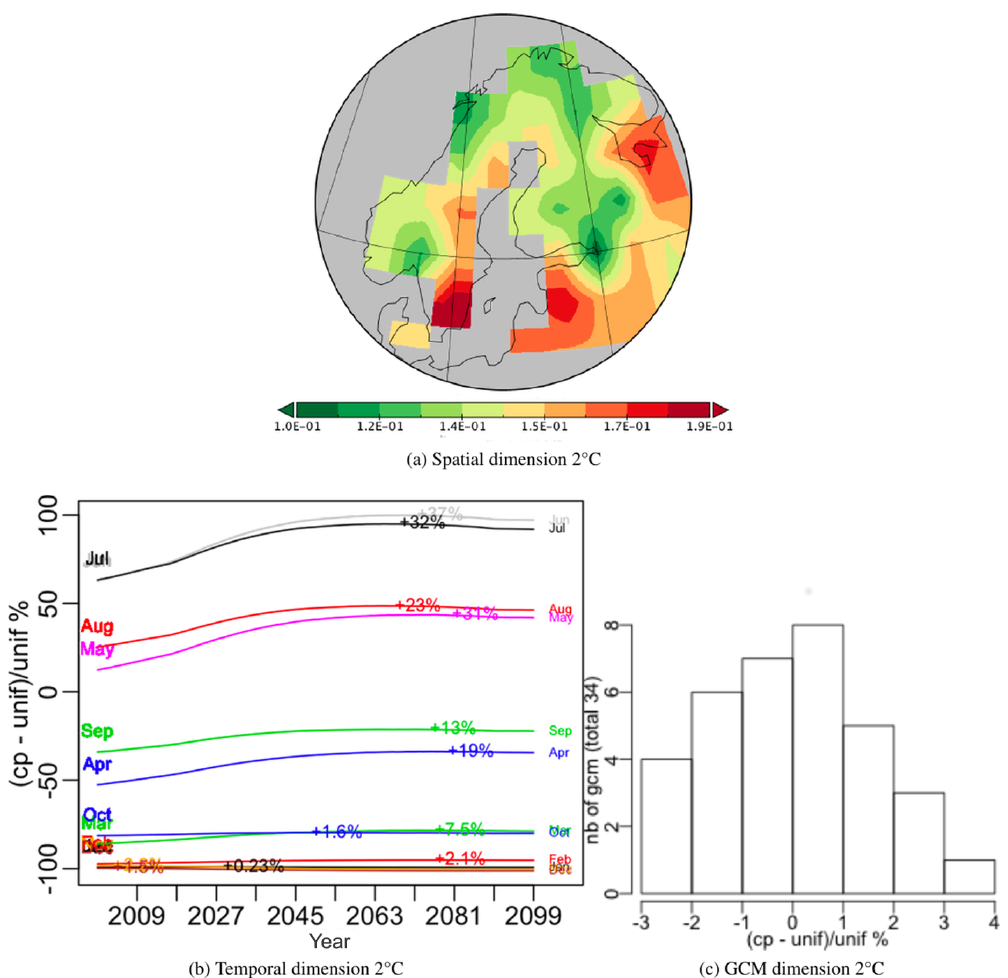
Figure 13. Components of the best principal tensor from the PTA3 analysis of NPP for JULES driven by 34 different GCMs (using IMOGEN) under the + 2 ◦ C target scenario. For the temporal and GCM dimensions the percentage relative difference from uniform weighting, 100 × ( cp − unif )/ unif, of the component weights is plotted, where “cp” and “unif” refer to component weights and uniform weighting respectively. On the temporal plot the increase for each month between 2000 and the maximum value is indicated as an absolute increase above the 2000 value. The GCM weights are shown as a histogram but individual weights are given in Appendix